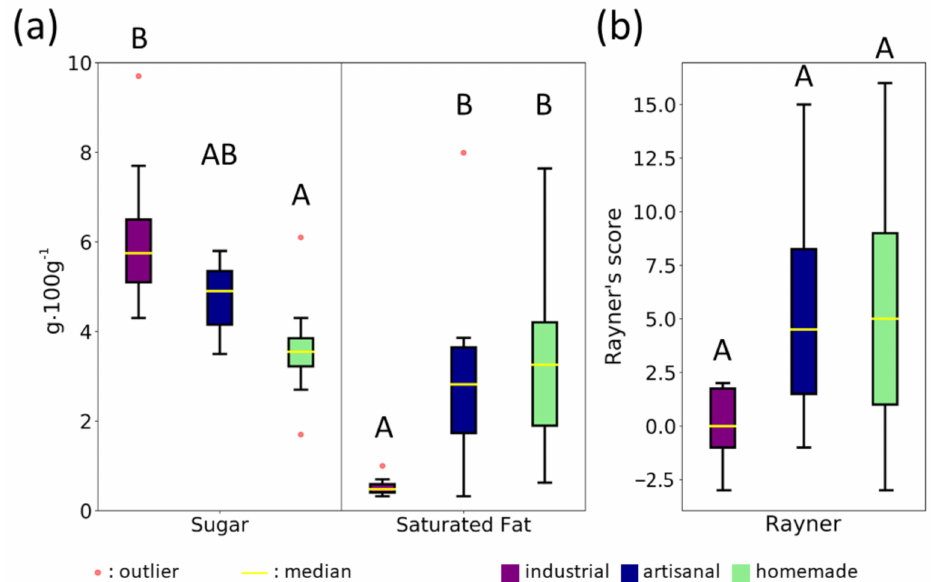
Figure 2. Nutritional comparison of the three processing methods. ( a ) Sugar and saturated fat content; ( b ) Rayner’s nutritional quality score. Data are represented by boxplots (1st and 3rd quartiles, median ± 1.5 × interquartile range for the whiskers), and statistically different groups are indicated with letters (according to post hoc Tukey or Conover-Iman tests,